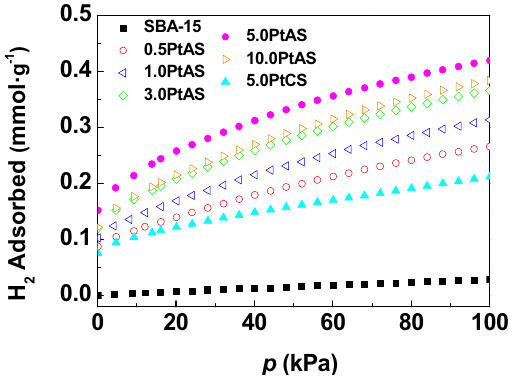
Figure 8. Hydrogen adsorption isotherms at 298 k for the samples of SBA-15, PtAS, and